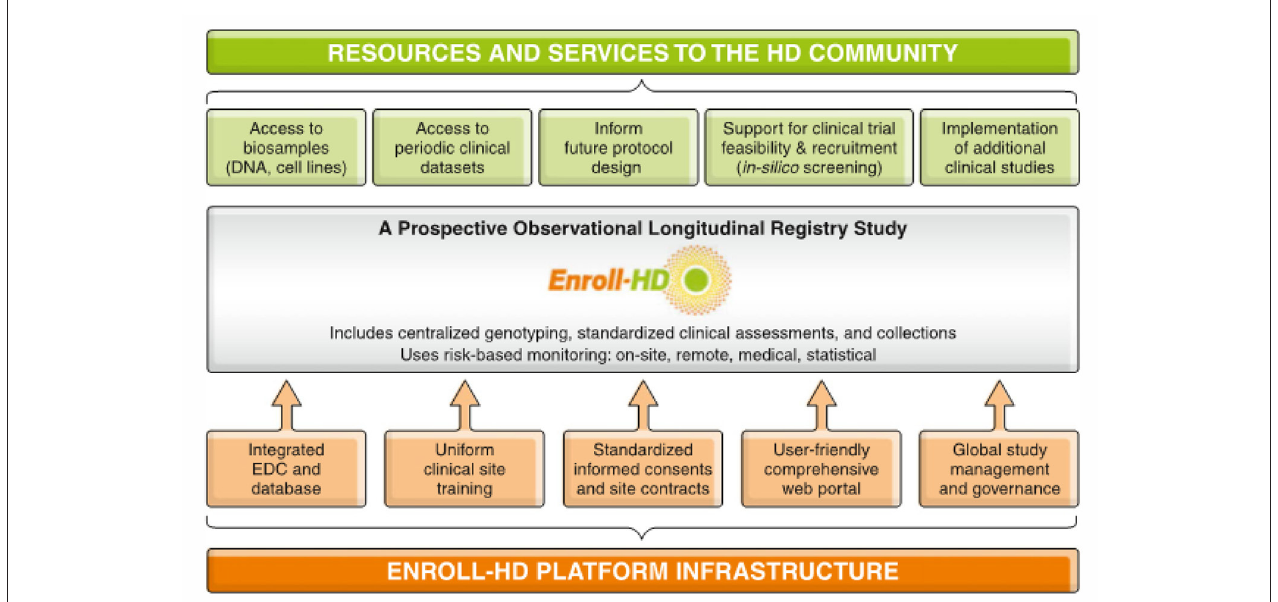
FIGURE 1 | Schematic outlining the Enroll-HD clinical research